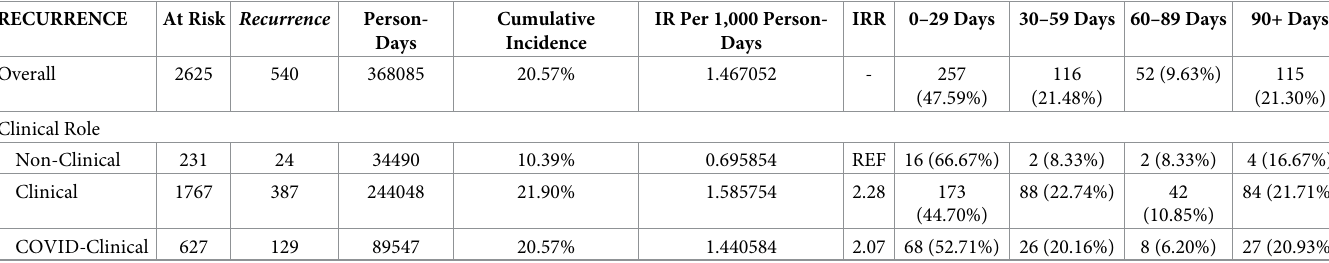
Table 3. Incidence measures representing risk of COVID-19